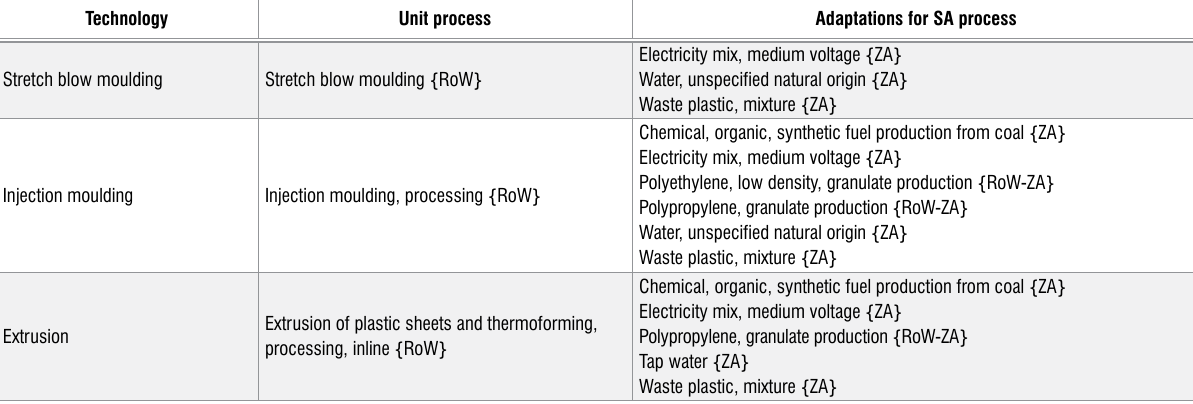
Table 2: Data source and adaptations for conversion processes